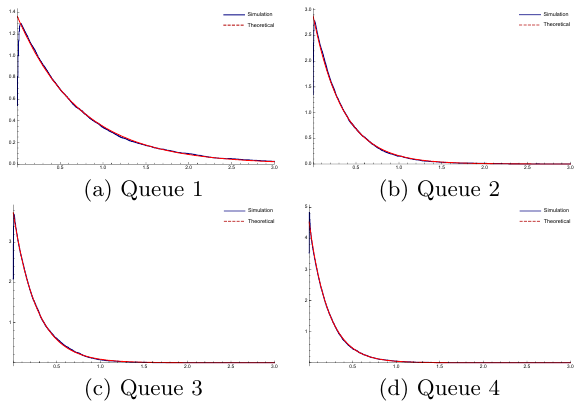
Figure 4: Simulated and theoretical scaled queue lengths for Example 4.